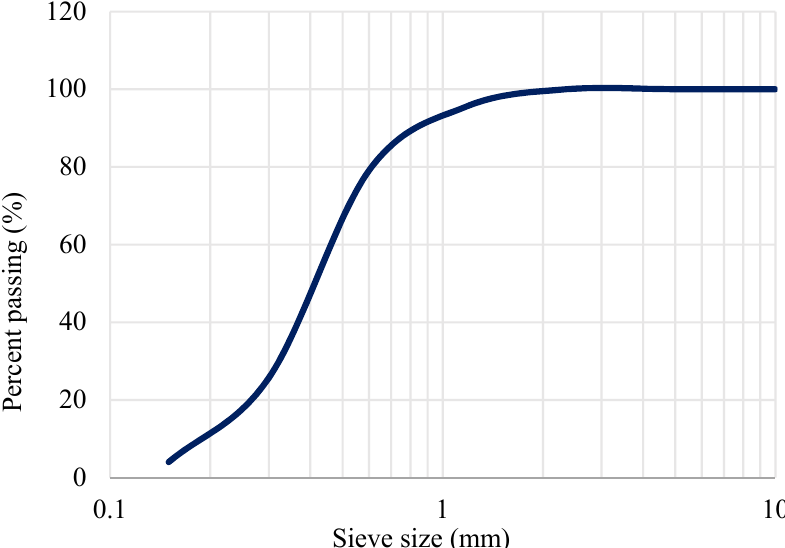
Figure 1. Grains’ size distribution curve. Tire Shreds